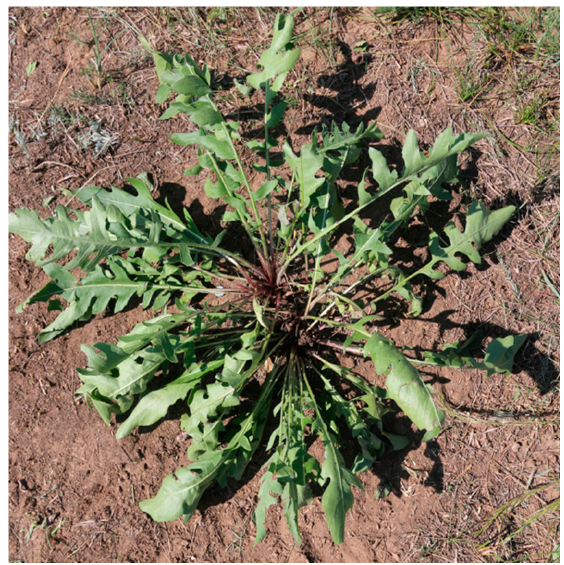
Figure 9. Photo of Cichorium intybus from Baiyinkulun Grassland. Stipa capillata